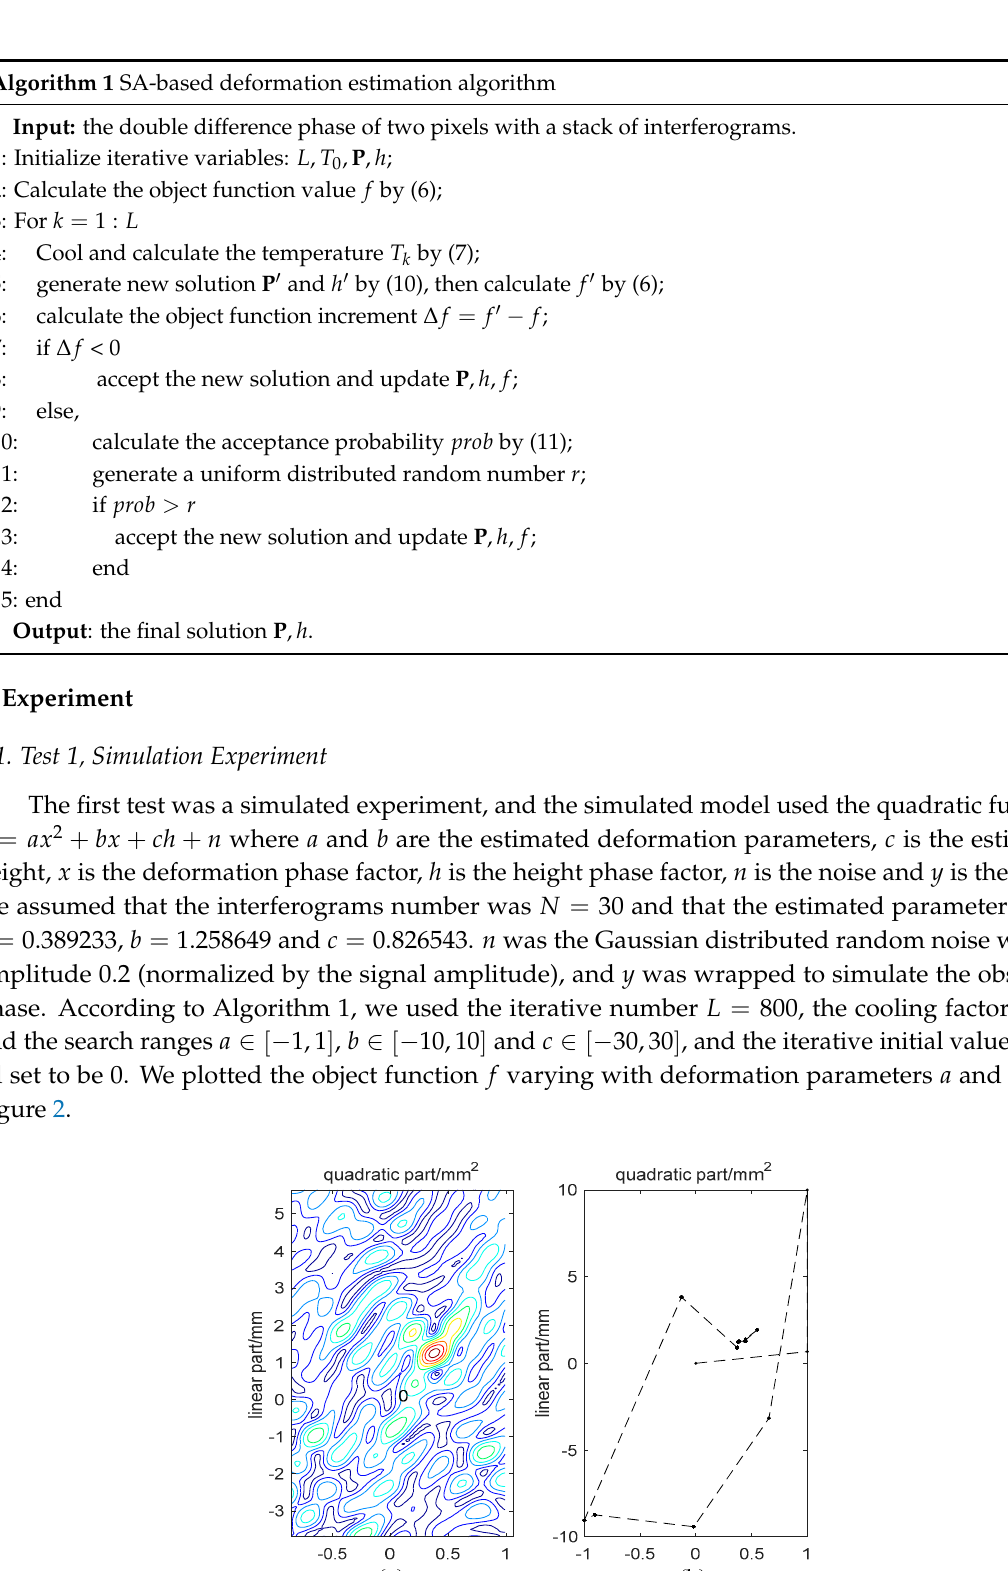
Figure 2. ( a ) The object function f varies with a and b , with the range a ∈ [ − 1,1 ] , b ∈ [ − 10,10 ] ; and ( b ) the search process for SA-based algorithm.